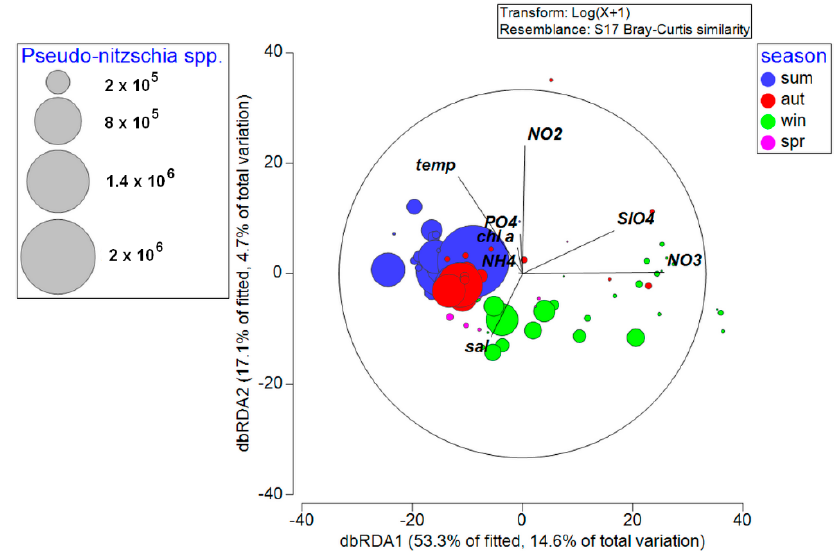
Figure 10. Distance-based redundancy analysis plot (dbRDA) of phytoplankton assemblage and environmental parameters (temp: temperature, sal: salinity, chl a : chlorophyll a concentration, NO 3 − : nitrates, NO 2 − : nitrites, NH 4 + : ammonia, PO 4 3 − : orthophosphates, SIO 4 2 − : orthosilicates). Bubbles present Pseudo-nitzschia spp. abundance in different seasons.